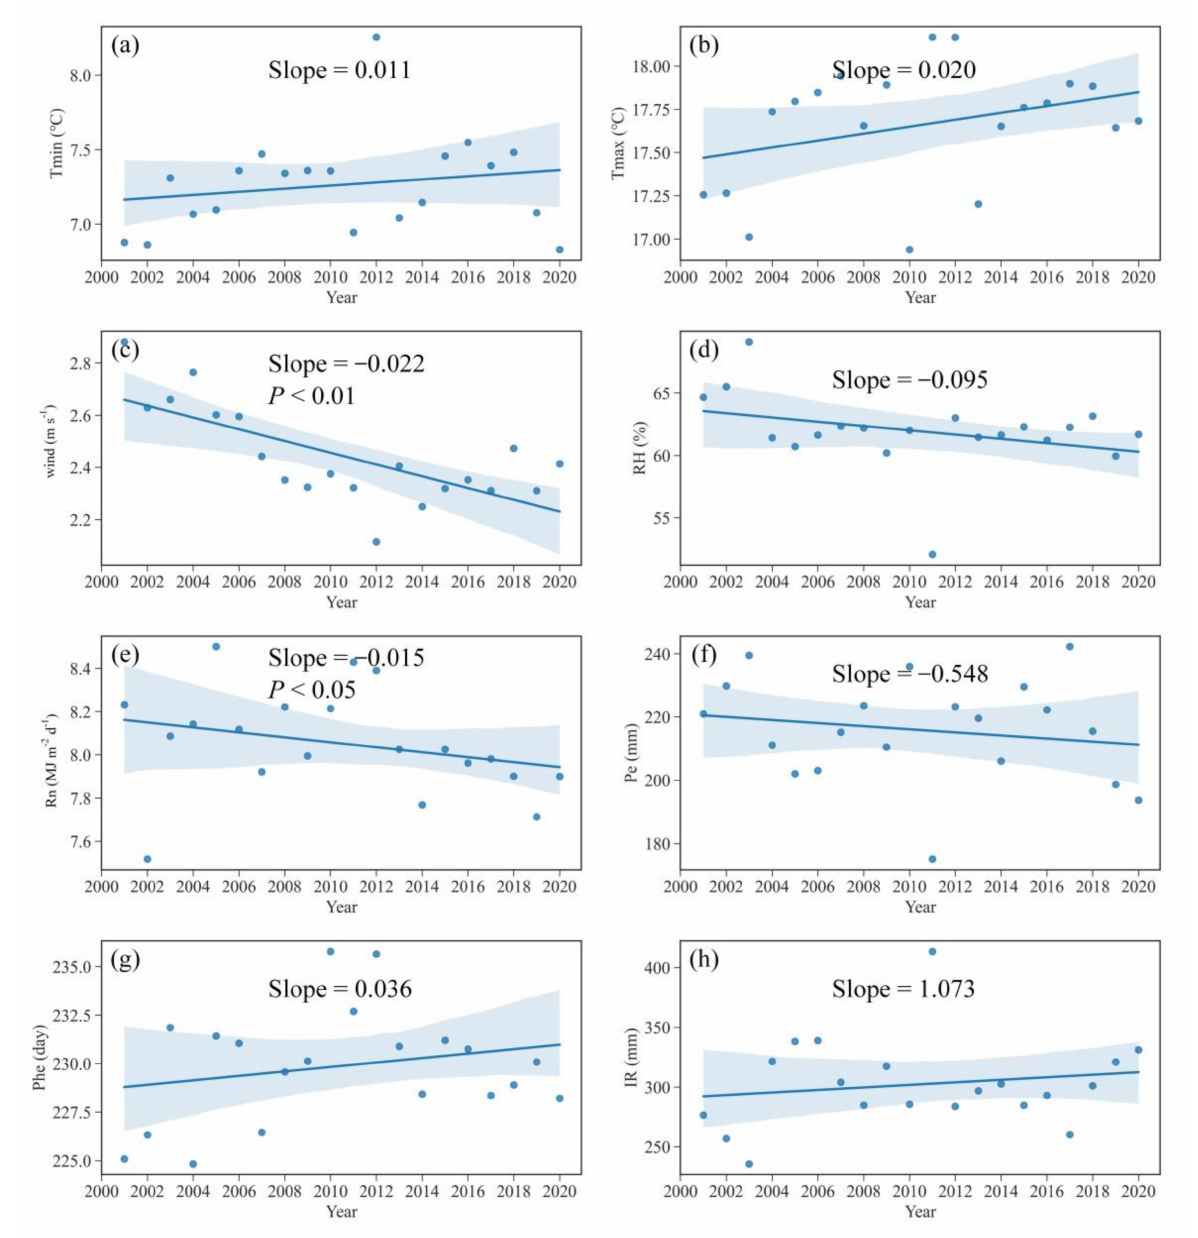
Figure 2. Trends in Tmin ( a ), Tmax ( b ), wind ( c ), RH ( d ), Rn ( e ), Pe ( f ), Phe ( g ) and IR ( h ) and each impact factor in 2000–2020 ( p < 0.05 indicates significance; p < 0.01 indicates high